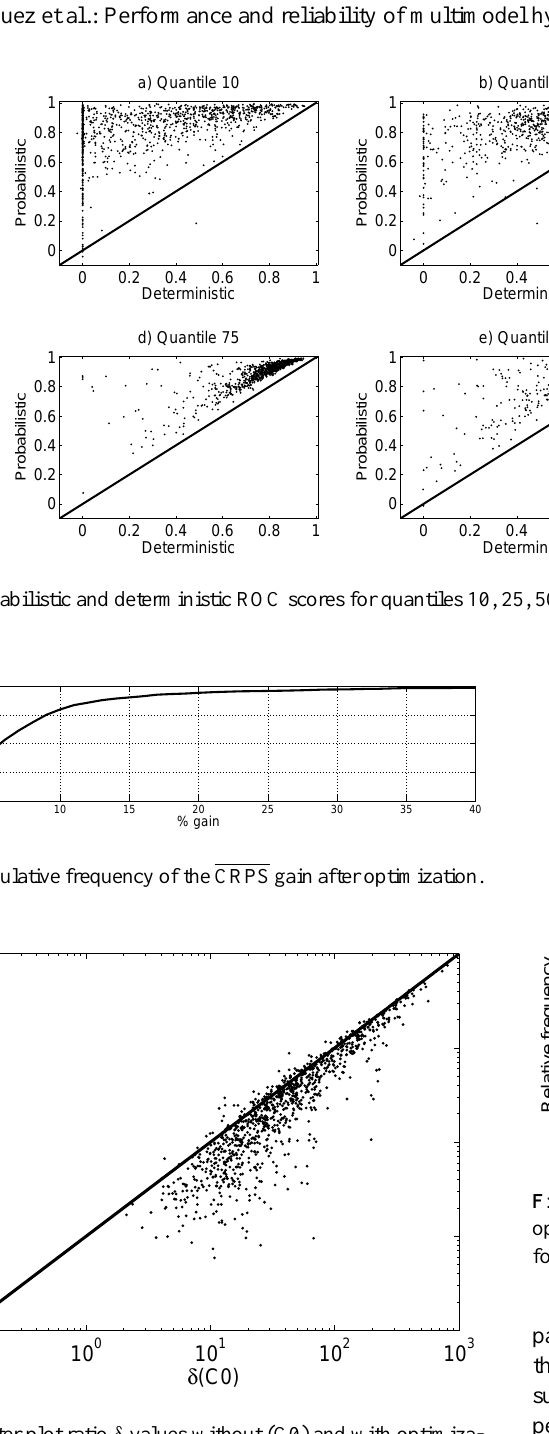
Fig. 12. Scatter plot ratio δ values without (C0) and with optimiza- tion